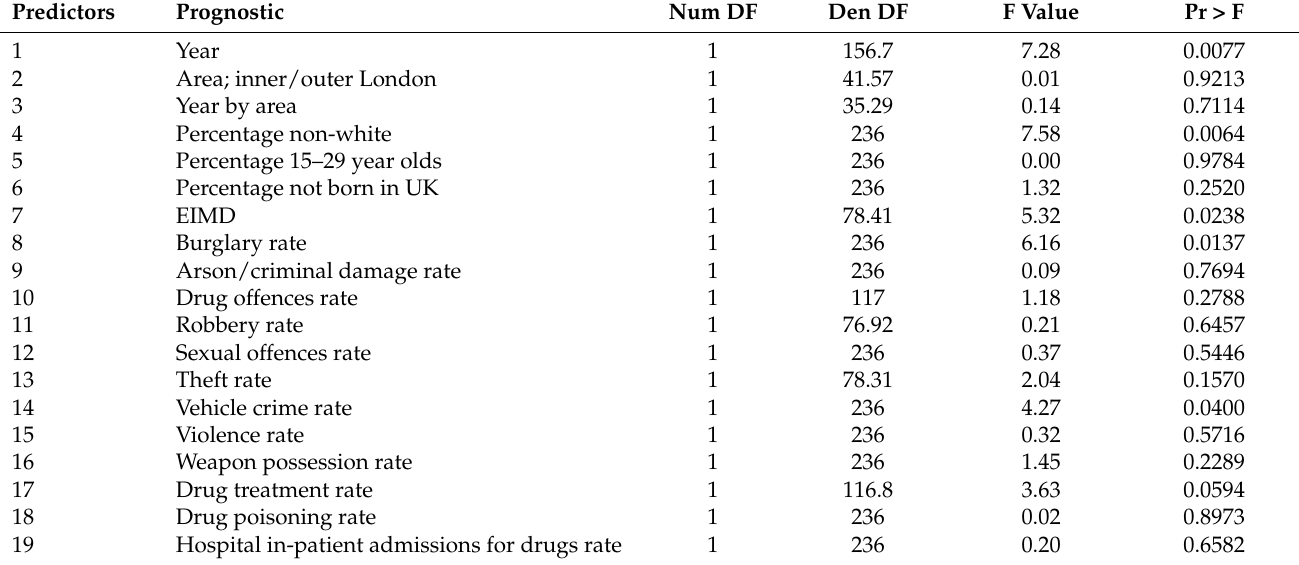
Table 4. Type III tests of fixed